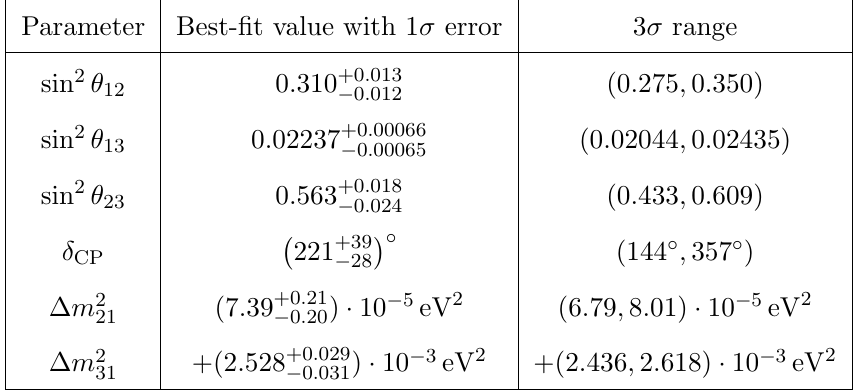
Table 7 . Current best-(cid:12)t values of the leptonic mixing parameters with their corresponding 1 (cid:27) errors and 3 (cid:27) ranges from NuFIT 4.1 [July 2019, NO with atmospheric neutrino oscillation data from Super-Kamiokande (SK)], see ref.